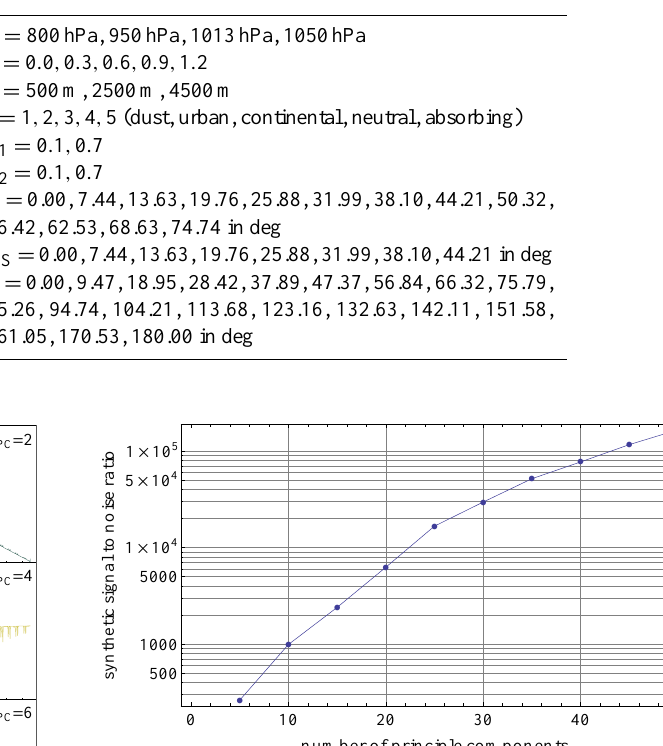
Table 1. Parameter grid of the lookup table. The table contains 4 × 5 × 3 × 5 × 2 × 2 × 13 × 8 × 20 = 2 496 000 states and corresponding spectra.